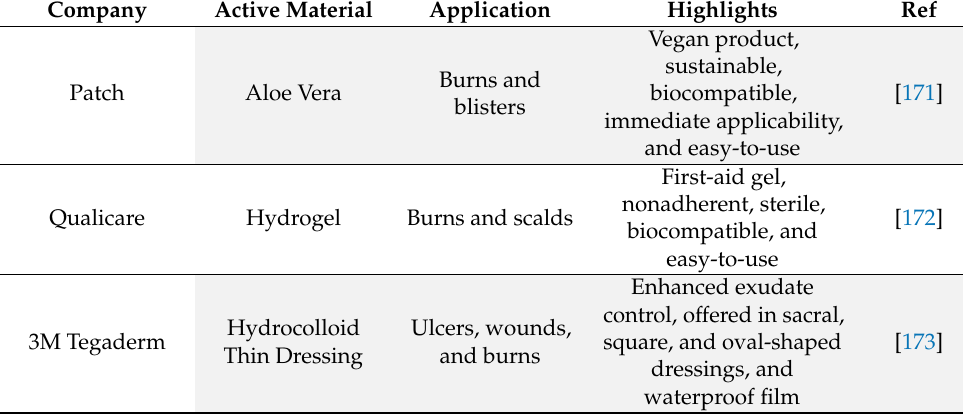
Table 6. Sustainable Commercial